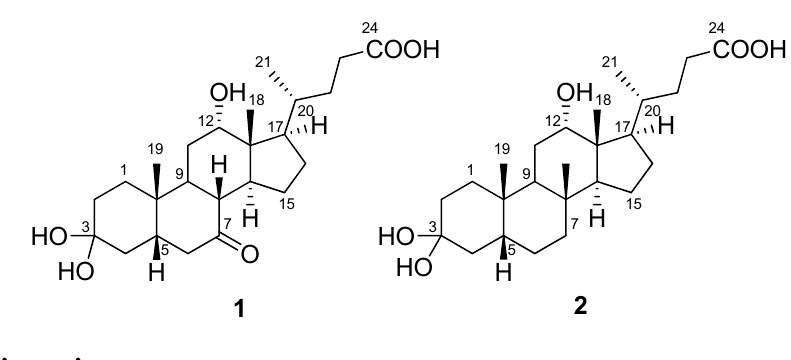
Figure 1. Structures of compounds 1 and 2